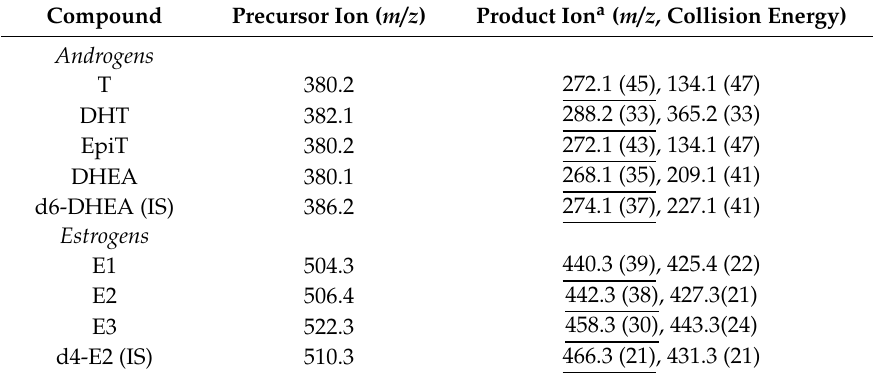
Table 3. Precursor ions, product ions optimized MS information for androgens and